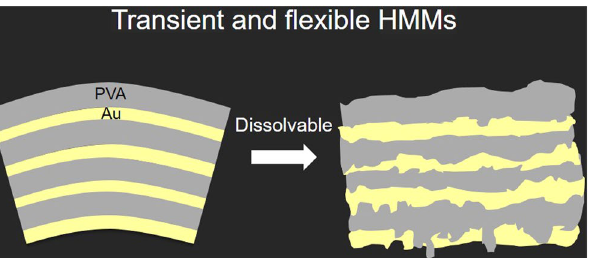
Figure 1. Proof of concept design of transient and flexible hyperbolic metamaterials (HMMs). Schematic diagram of transient and flexible HMMs is illustrated.